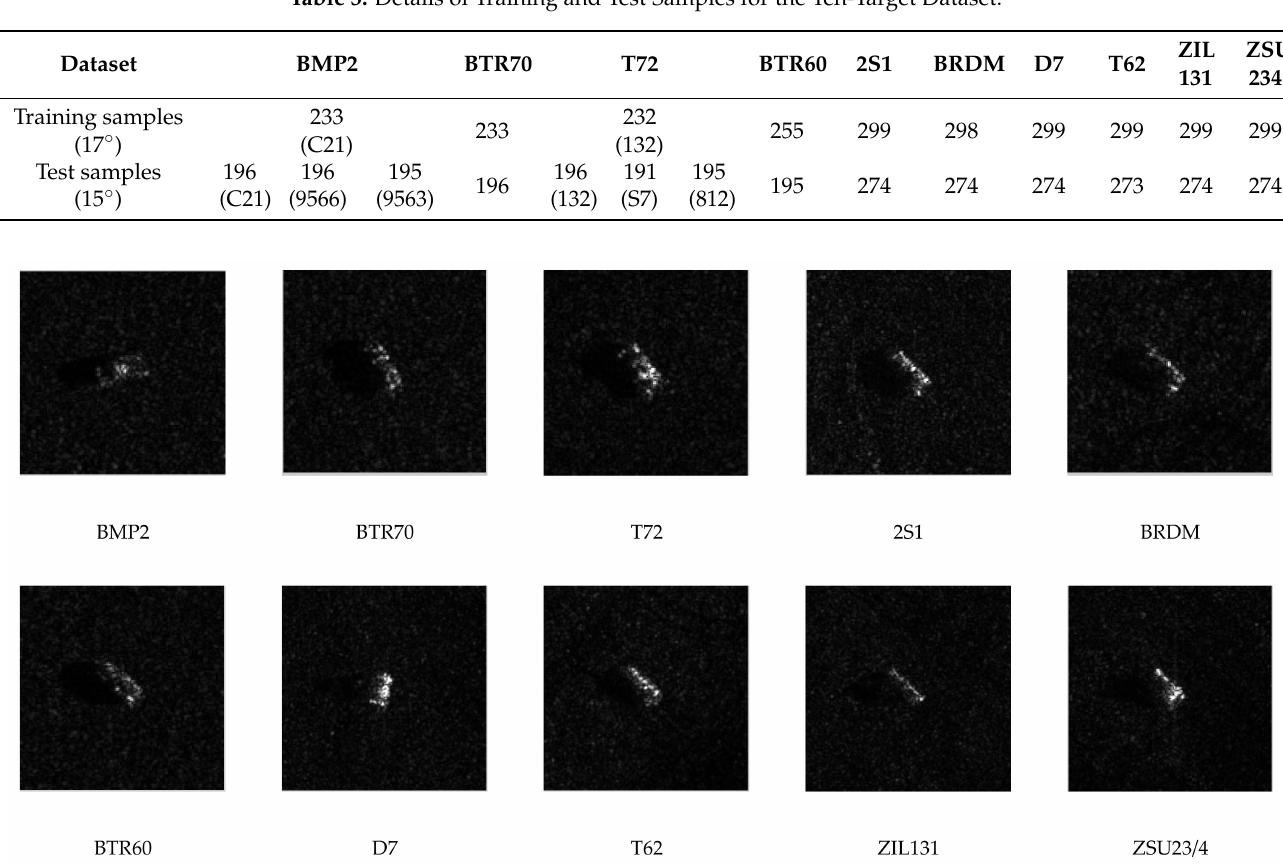
Figure 5. SAR image examples of ten different targets in the MSTAR dataset.